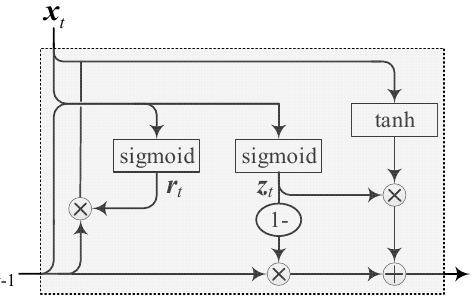
Figure 1. The network structure of GRU.